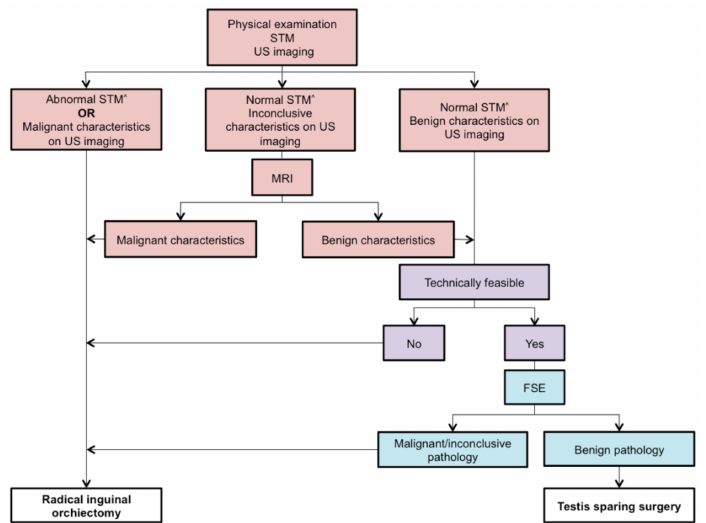
Figure 1. The algorithm for surgical approach in prepubertal boys less than 12 years of age with tes- ticular tumors, based on the results of our recent systematic review. STM: serum tumor marker; FSE: frozen section examination; ˆ: according to the age-specific range; • : preoperative; • : preoperative and intraoperative; • : intraoperative.